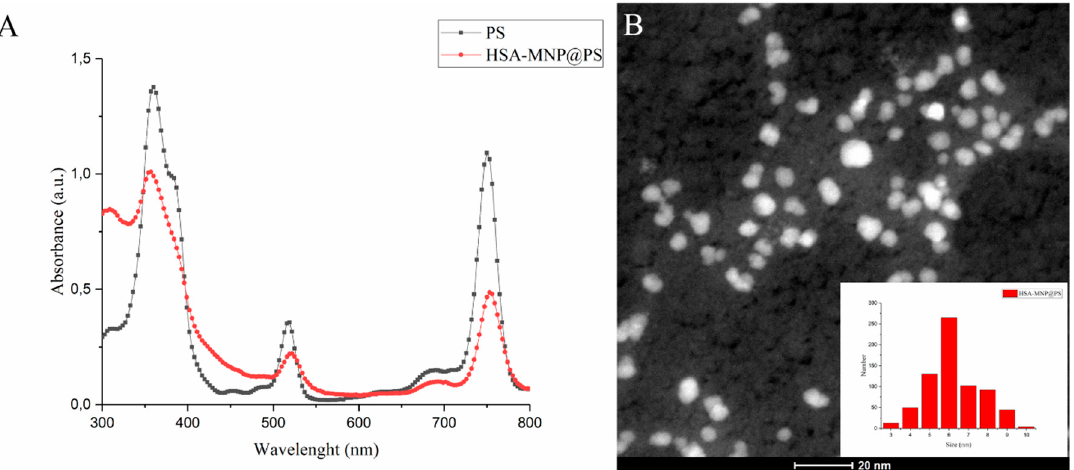
Figure 1. Physical properties of MNP-HSA@PS. Absorption spectrum of PS in DMSO and MNP-HSA@PS in water ( A ); HR-TEM images and size distribution of MNP-HSA@PS ( B ).